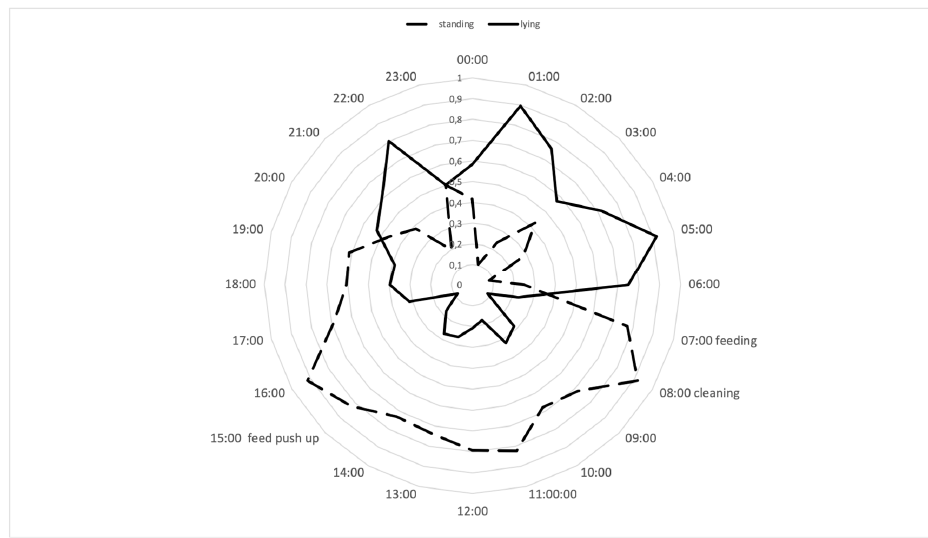
Figure 5. Means of lying and standing behaviour at h of the day.